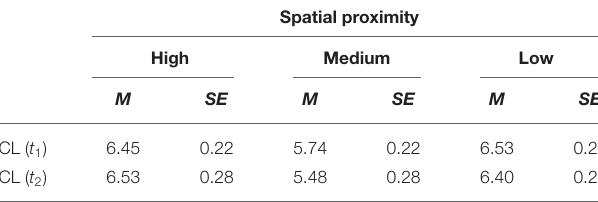
TABLE A2 | Descriptive data from Experiment